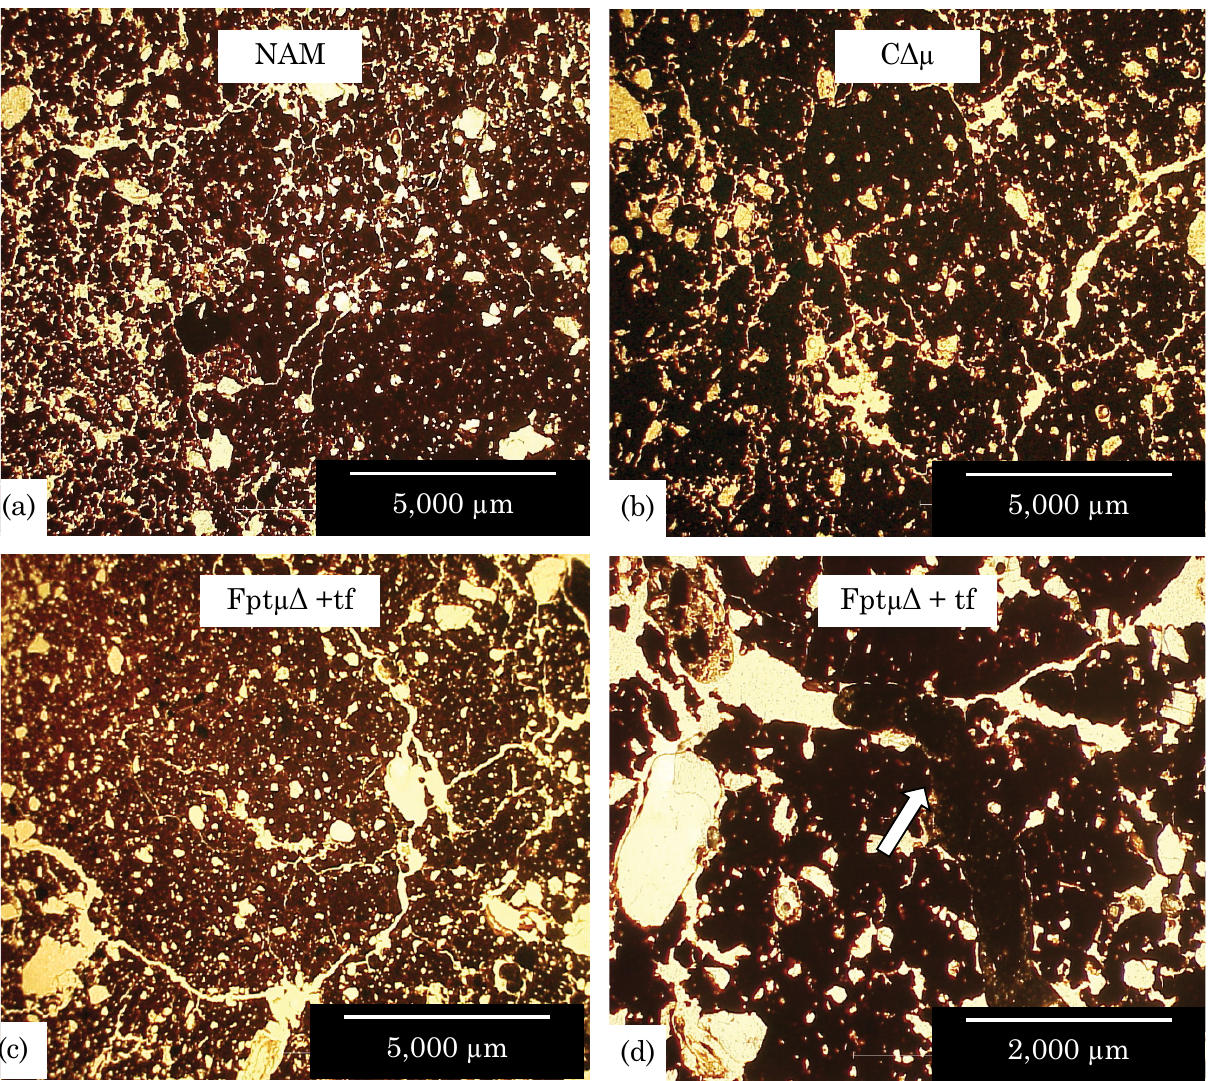
Figure 3. Photomicrographs of the porosity predominant in different units described in the Memory plot: (a) porphyric-enaulic relative distribution; (b) porphyric relative distribution with coalescence of aggregates and horizontal cracking; (c) microstructure in subangular blocks with moderately to strongly developed pedality and partially accommodated aggregates; and (d) detail of excrement pedofeatures (coprolites). L: volume of loose soil, not compact, “powdered L: volume of loose soil, not compact, “powdered”; F or C: fragmented or continuous volumes of soil; ∆μ or μ∆: compact or porous clods, with very compact aggregates (∆), compact (∆μ) and in compaction process (μ∆); pt, mt, gt: small, medium or large clods; tf: fine soil; and NAM: not altered by